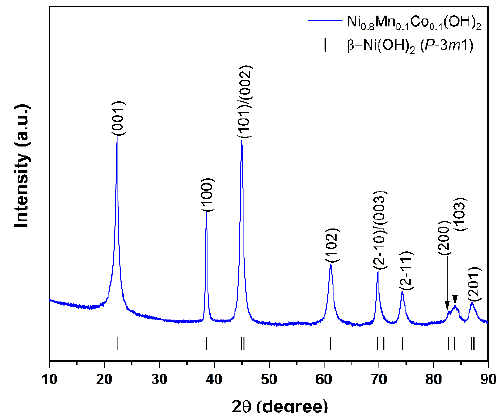
Figure 2. Powder XRD pattern (blue curve) of the MW_30m Ni 0.8 Mn 0.1 Co 0.1 (OH) 2 precursor. Bragg reflection positions for the β -Ni(OH) 2 structure are marked with black vertical lines.